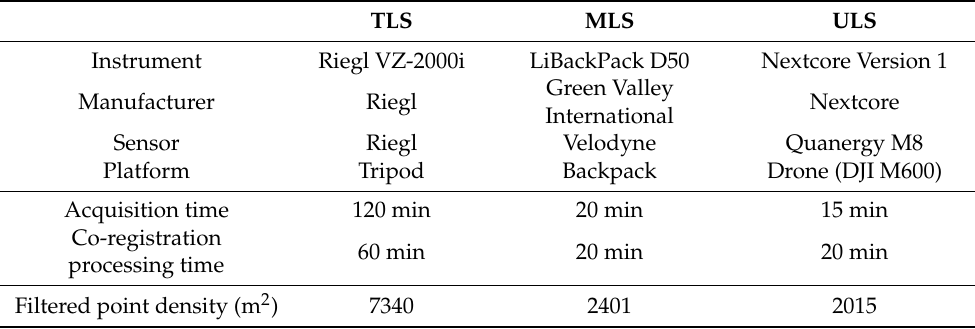
Table 1. Instrument, surveying, and processing characteristics of the three LiDAR systems. Reported point densities are after the application of a 0.01 m sub-sampling spatial filter. Note: TLS = terrestrial laser scanning, MLS = mobile laser scanning, ULS = UAV laser